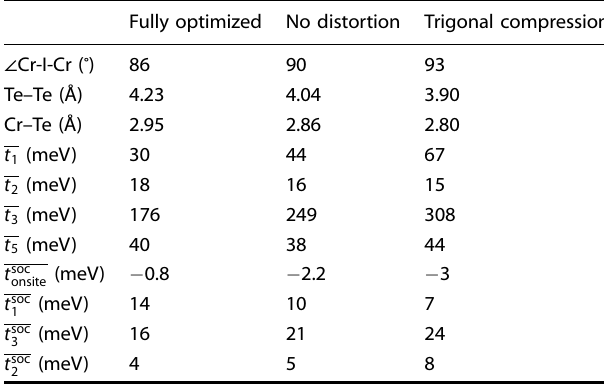
Table 3. Structure and hopping parameters of fully optimized, cubic, trigonally compressed structure.